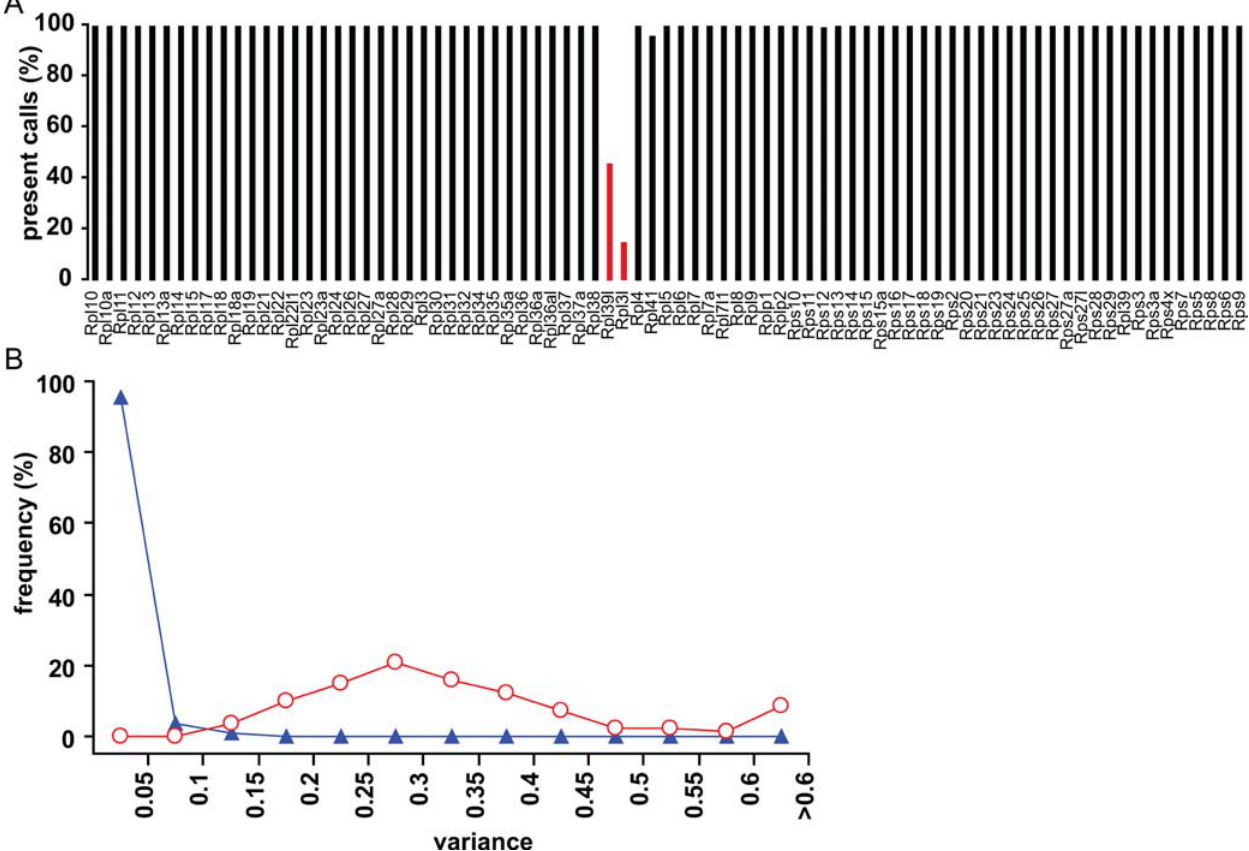
Figure 1. Housekeeping versus reference gene status of 81 ribosomal protein genes. (A) Percentage of present expression calls tested in 22 different mouse tissues (3–5 replicates per tissues, in total 70 arrays). Most ribosomal protein genes were present in all tissues examined and thus can be called housekeeping genes. Exceptions were Rpl39l and Rpl3l . (B) Variance of expression levels within replicates of tissues, representing biological variation between animals and technical error on measurements (triangles) compared to variance of expression between tissues (circles). Variance within replicated measurements was significantly smaller than variance of expression between different conditions (Wilcoxon’s rank sum statistic: p ,